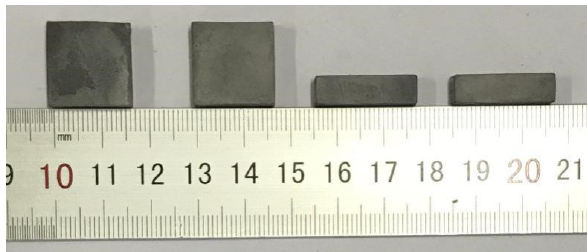
Figure 2: Macro-picture of gradient tool material prepared by mi- crowave sintering